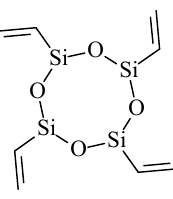
Figure 1. Cores for ethynylsilane (A) and siloxane tetramer cores